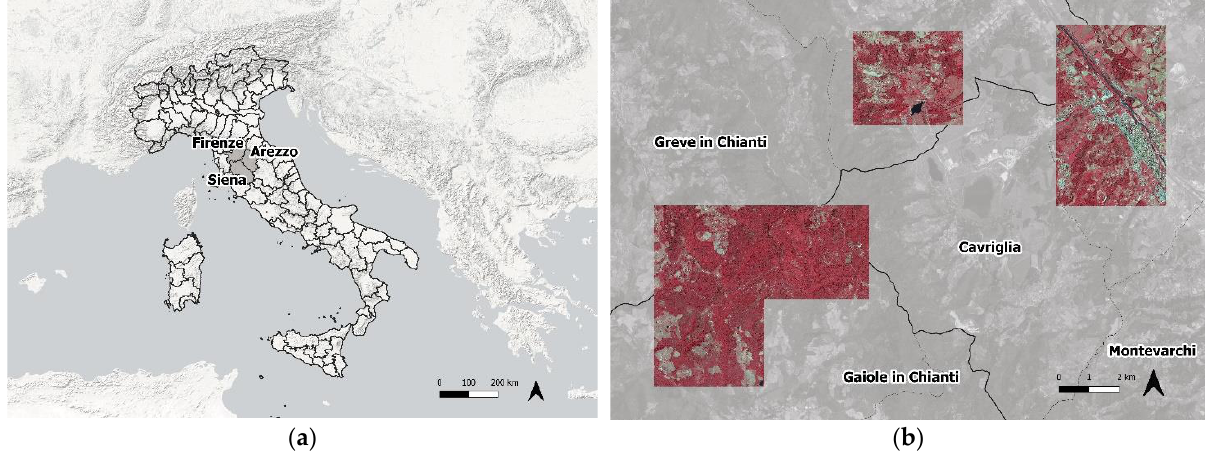
Figure 1. ( a ) Location of the study areas in Italy; ( b ) study areas.